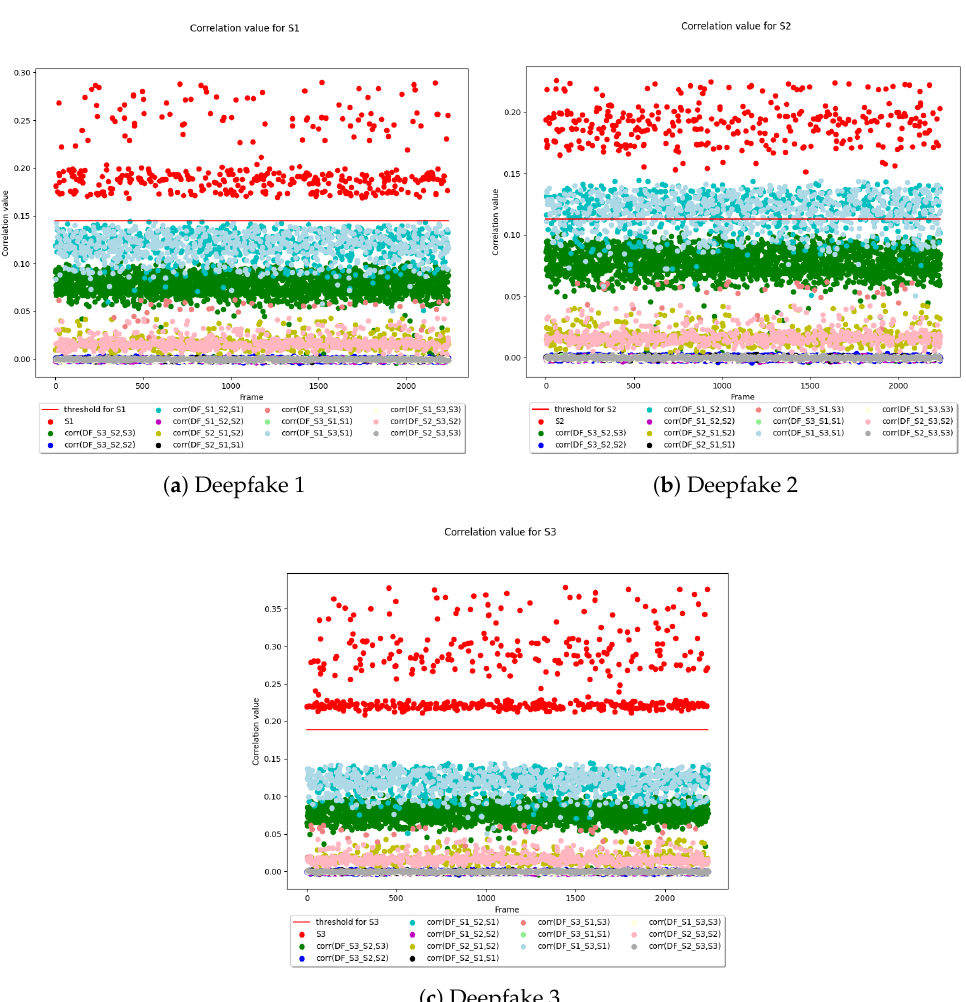
Figure 8. In each sub-figure, (1) the threshold θ , represented by a red line, and (2) the correlation between the RP devices and the RN videos are represented for each of the three devices. The points are plotted considering the original frame position in the videos ( x -axis) and the correlation value ( y -axis) between the RN (Residual Noise) extracted from the frame and the RP (Reference Pattern) of the camera under